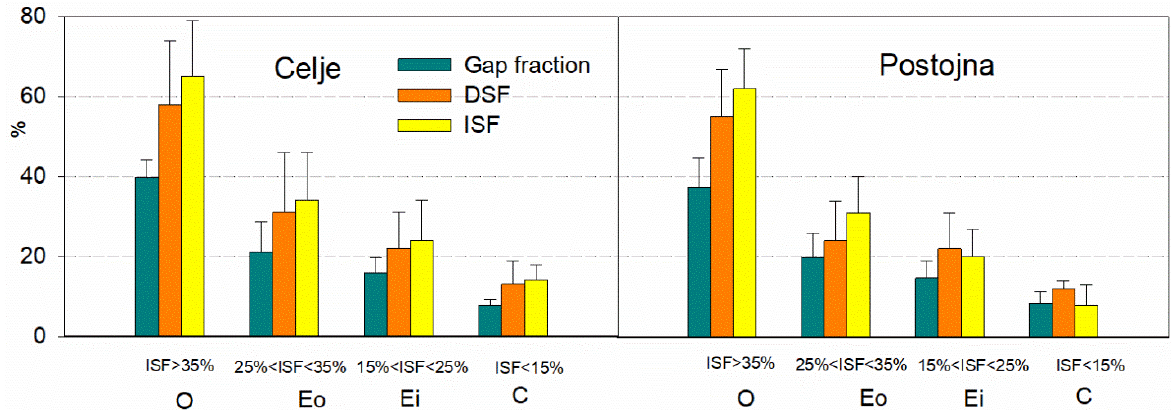
Figure 3. Light categories and different parameters from the hemispherical photo analysis at both sites. O-open; Eo- outer forest edge; Ei-inner forest edge and C-complete canopy cover. The bars are standard errors.